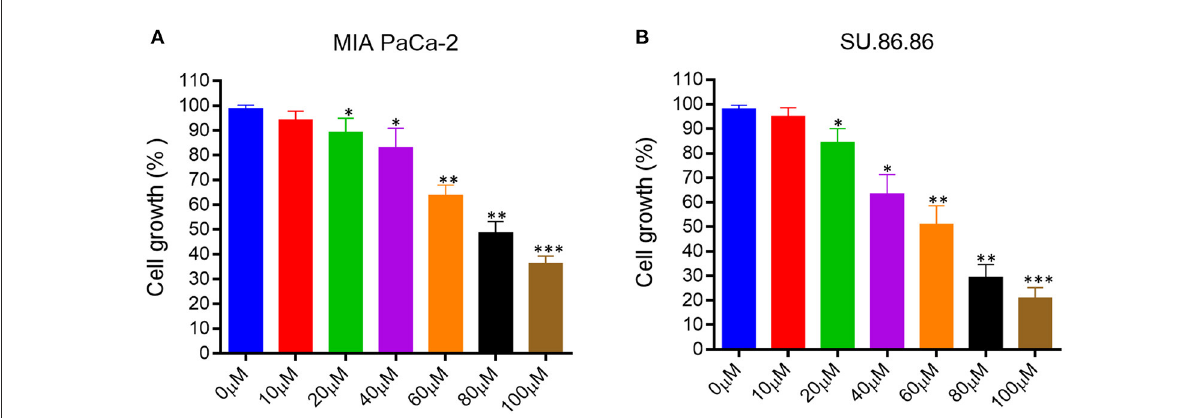
FIGURE4 Epigallocatechin gallate (EGCG) inhibits pancreatic cancer cell growth in vitro . Human pancreatic cancer cell lines were treated with various concentrations of EGCG (0–100 µ M), and cell growth was determined in MIA PaCa-2 (A) , and SU- 86.86 (B) cells after treatment with increasing EGCG concentrations for 24h. Cell growth was found to be inhibited in a concentration dependent manner. Results are expressed as a percentage of control and mean ± SD ( n = 4). * p < 0.05, ** p < 0.01, *** p < 0.01 vs.